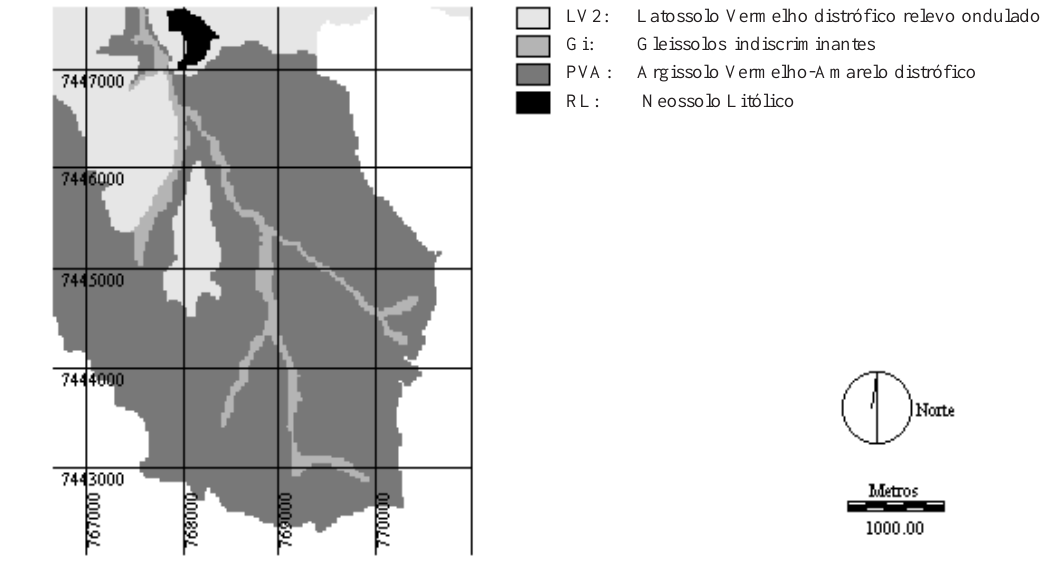
Figura 1. Mapa de solos (formato raster).